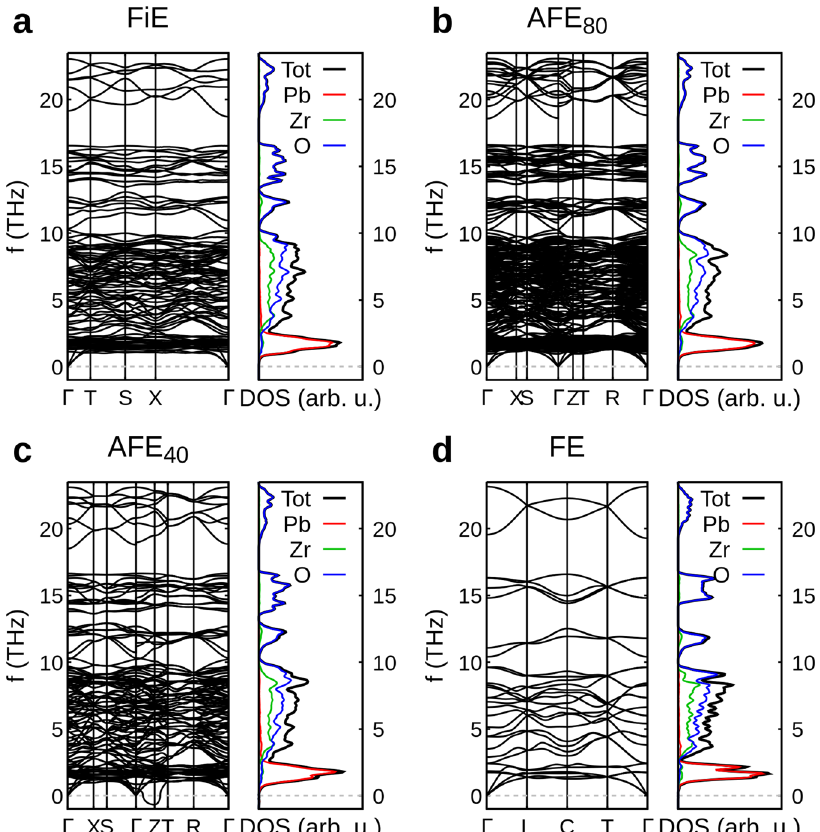
Fig. 4 Phonon band structure and phonon density of states of the studied PbZrO 3 phases computed with PBEsol. The results for the FiE, AFE 80 , AFE 40 and FE states are shown in panels a , b , c and d ,